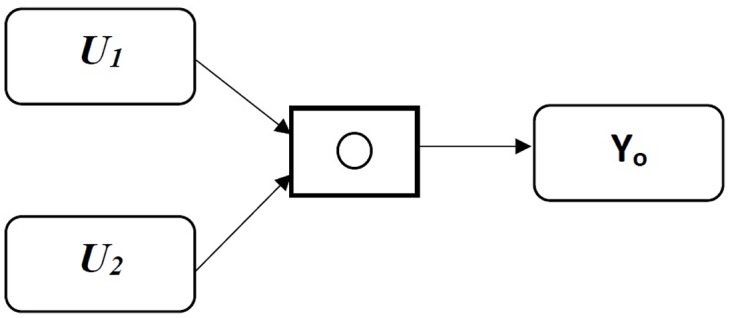
Analogical Gate.